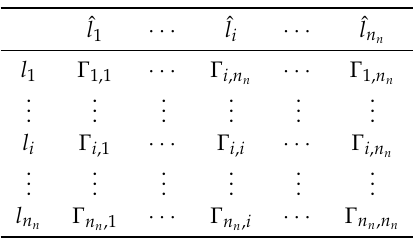
Table 1. Confusion matrix Γ